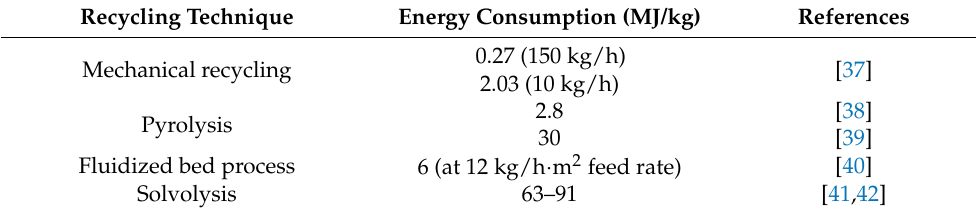
Table 3. Energy consumption levels of different recycling